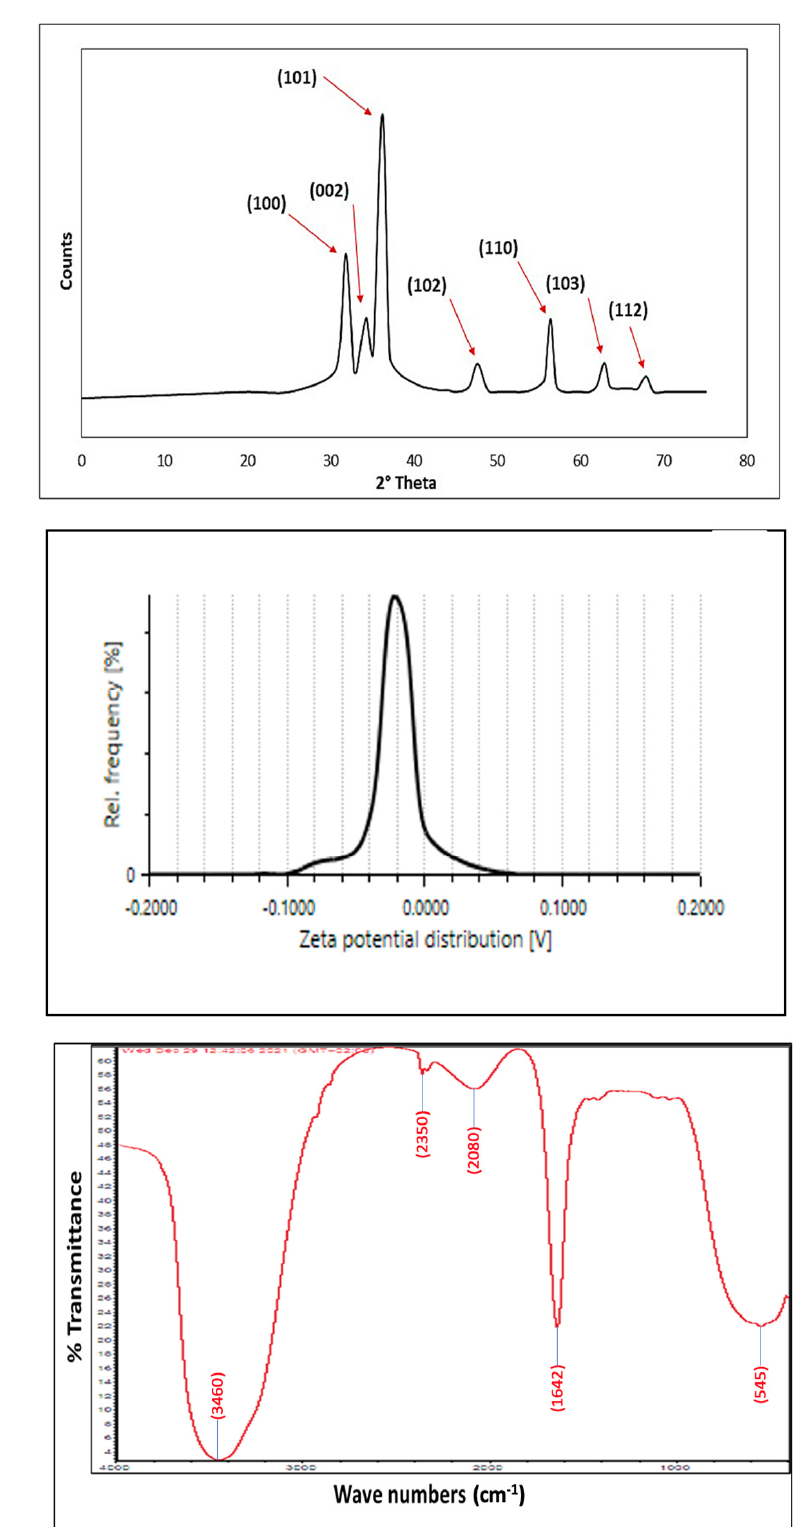
Figure 2. Characterization of Hi -ZnO-NPs mediated by Holothuria impatiens aqueous extract. ( A ) UV-visible spectrum of Hi -ZnO-NPs. ( B ) HR-TEM image and size distribution chart of Hi -ZnO-NPs. ( C ) XRD pattern of Hi -ZnO-NPs. ( D ) Zeta potential of Hi -ZnO-NPs. ( E ) FTIR of Hi -ZnO-NPs.